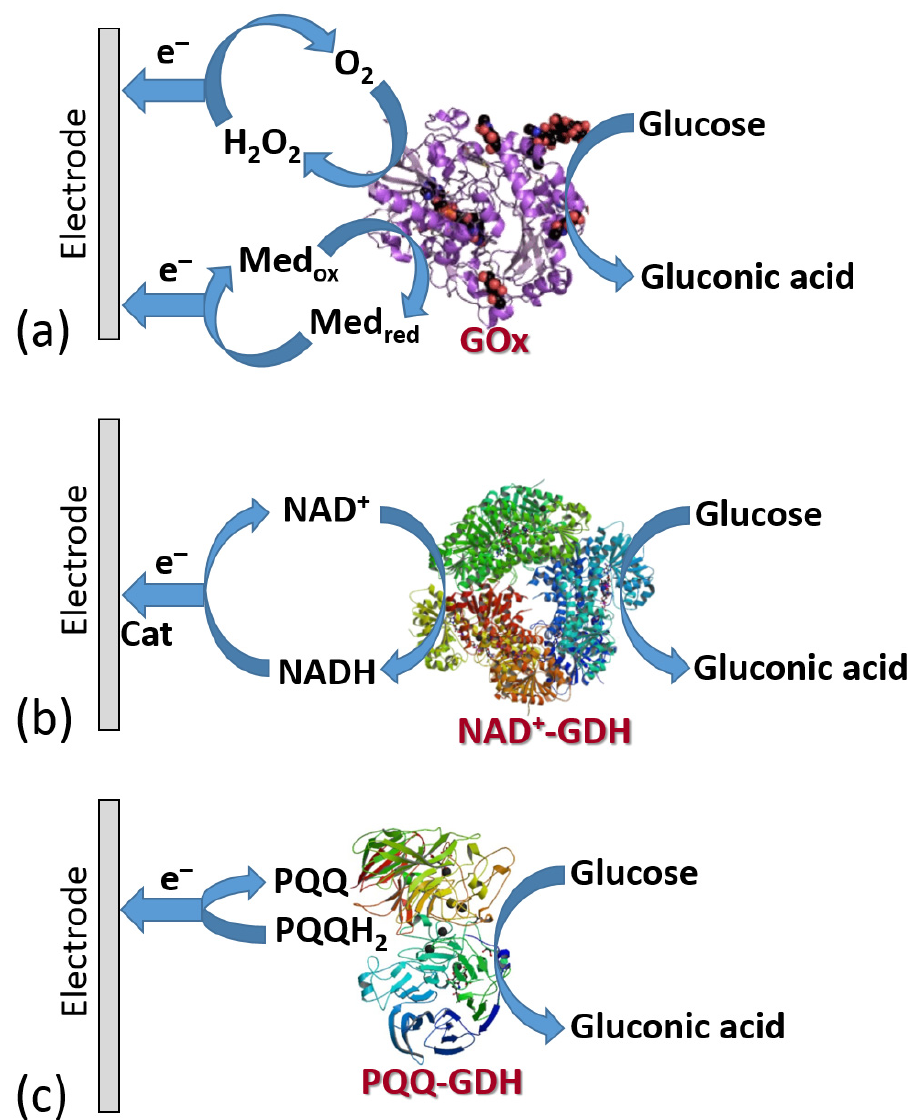
Figure 19. Bioelectrocatalytic processes involving different redox enzymes: ( a ) flavin adenine dinu- cleotide (FAD)-oxidases (exemplified with GOx), ( b ) NAD + /NADH-dehydrogenases (exemplified with NAD + -glucose dehydrogenase, NAD + -GDH); note that a catalyst, Cat, is usually required for recycling the NAD + /NADH cofactor), and ( c ) PQQ-glucose dehydrogenase (PQQ-GDH). All three enzyme classes are exemplified here with the enzymes oxidizing glucose.